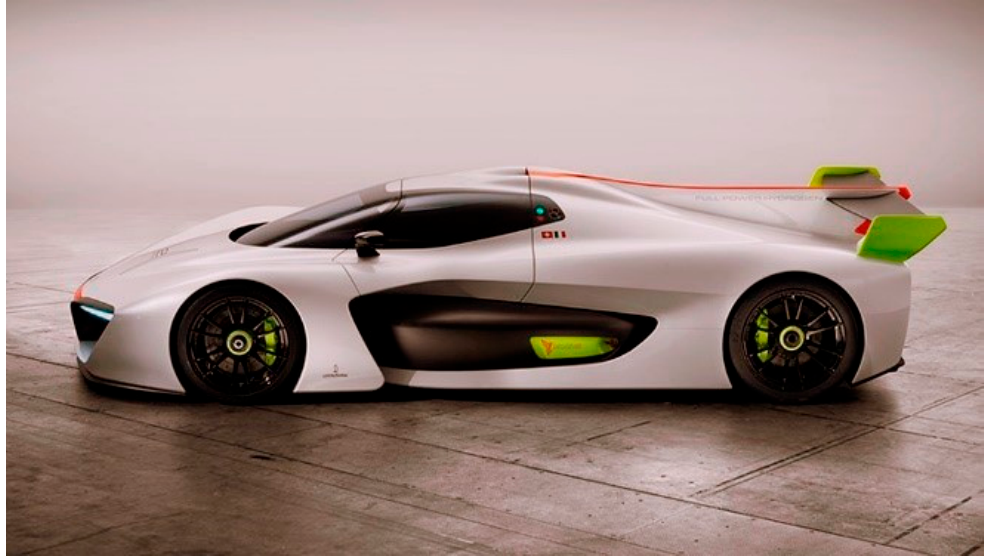
Figure 7. Pininfarina H2 Speed, a supercar employing hydrogen fuel cells.